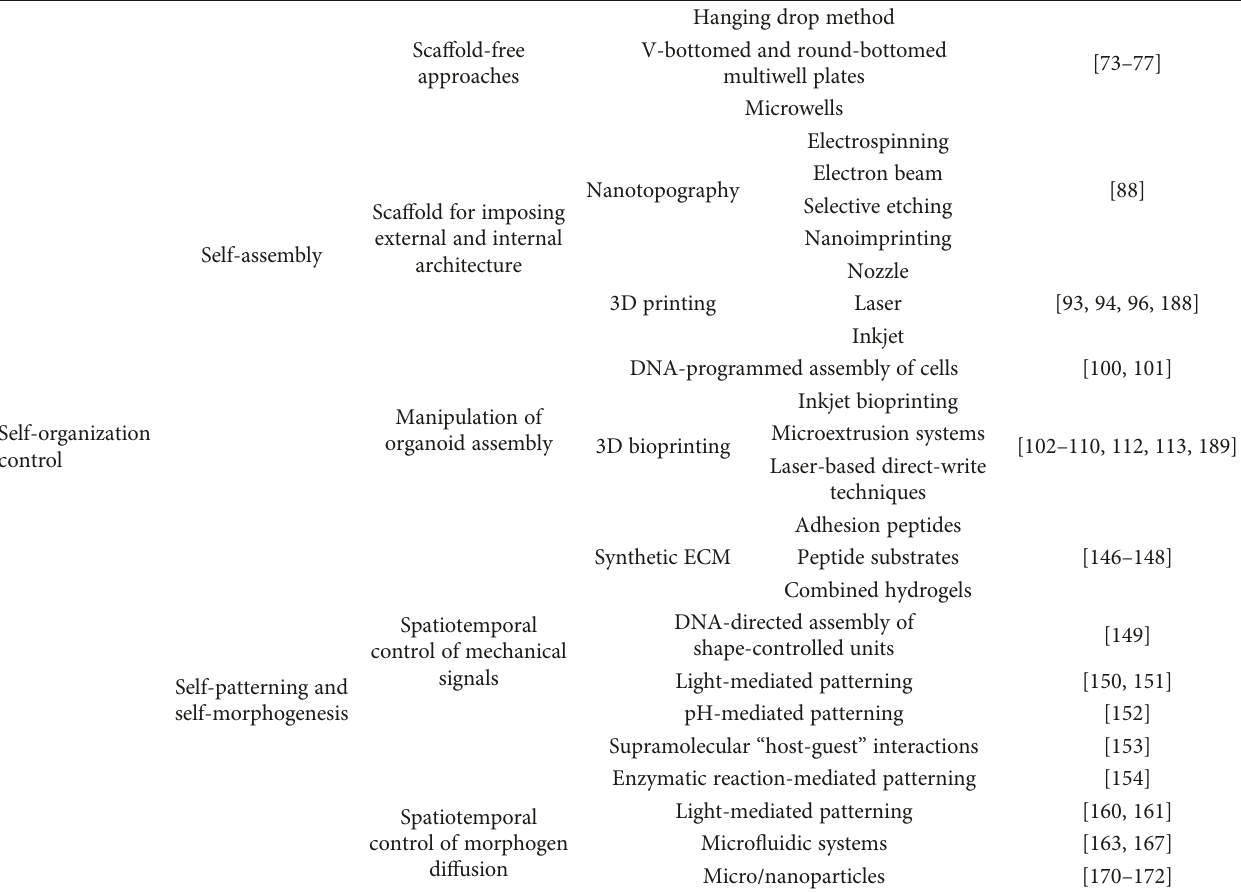
Table 1: Bioengineering approaches to control cell organization into PSC-derived